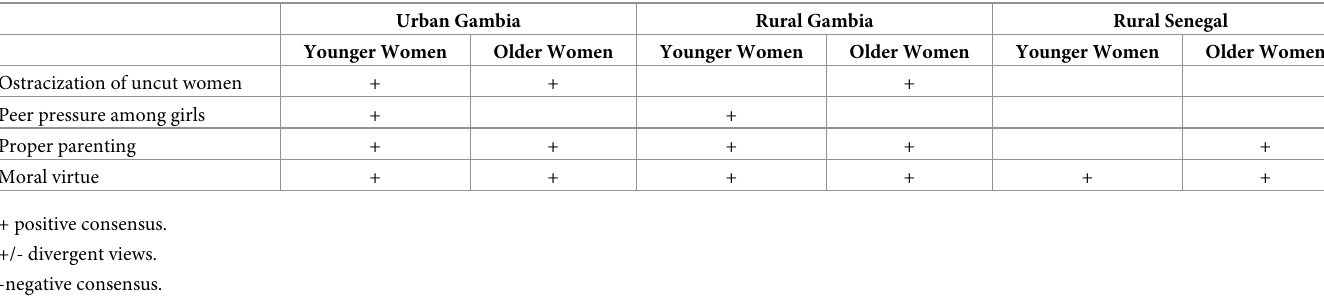
Table 1. Summary matrix of themes related to the overarching theme of pressure to